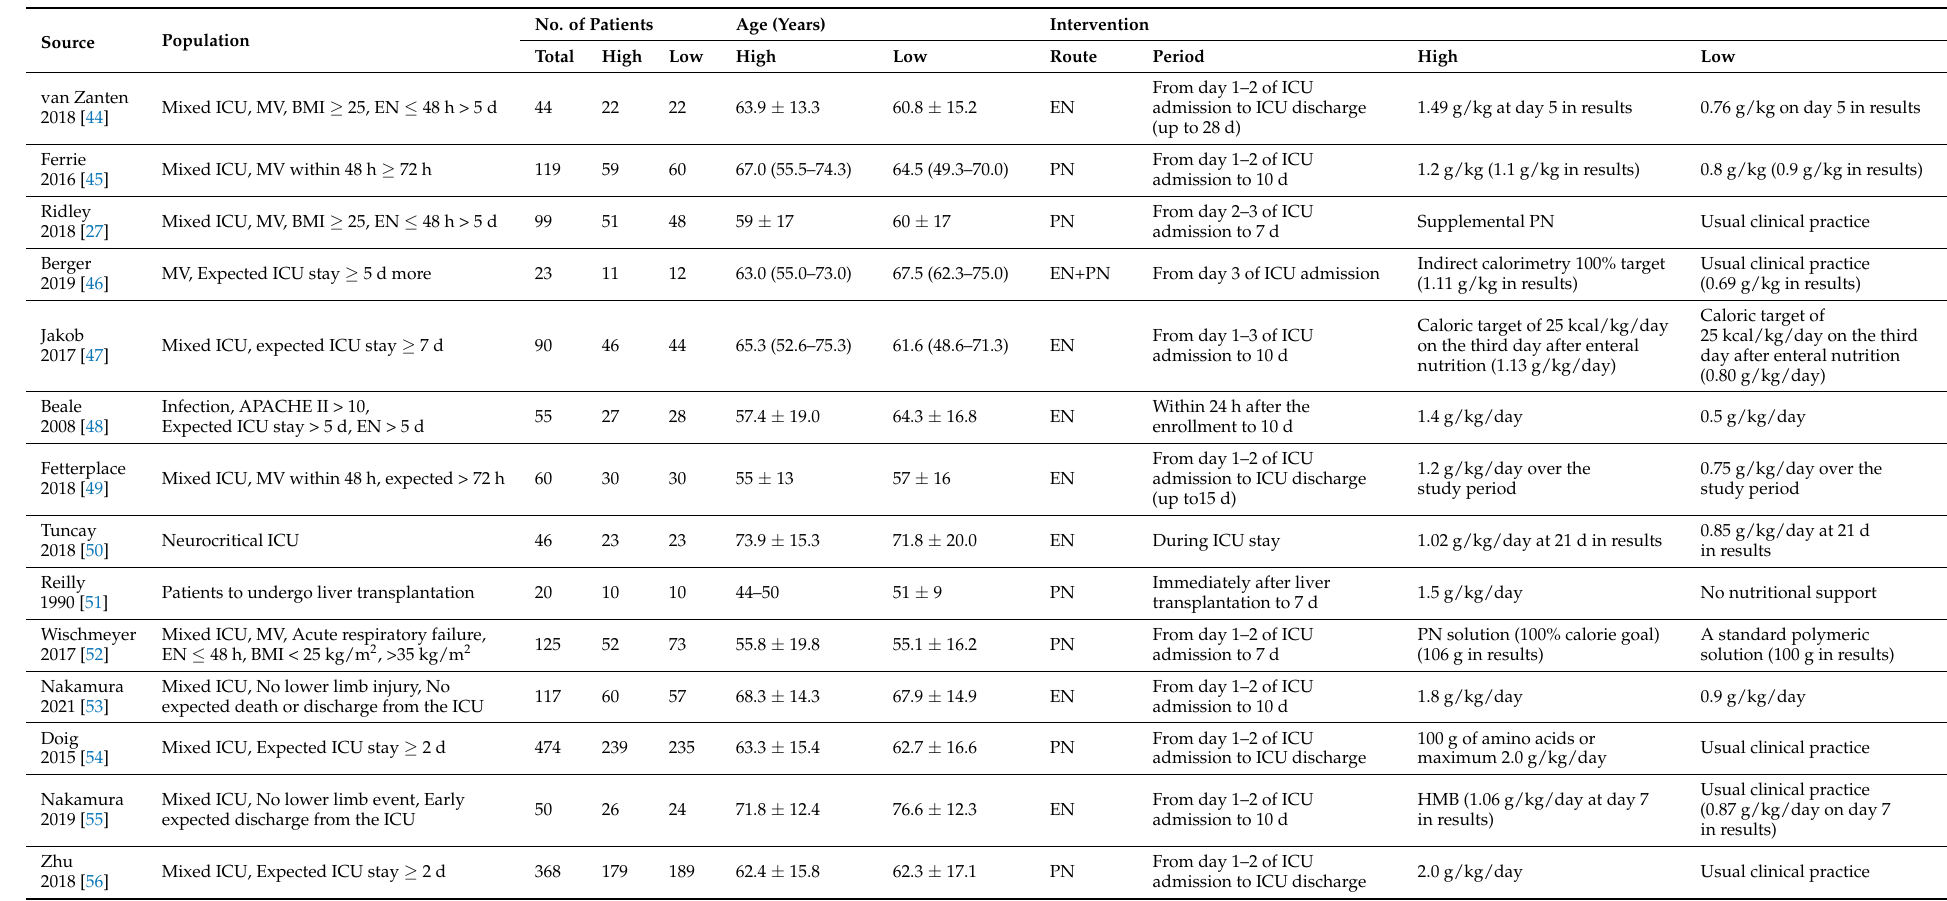
Table 2. Characteristics of included studies for optimal protein